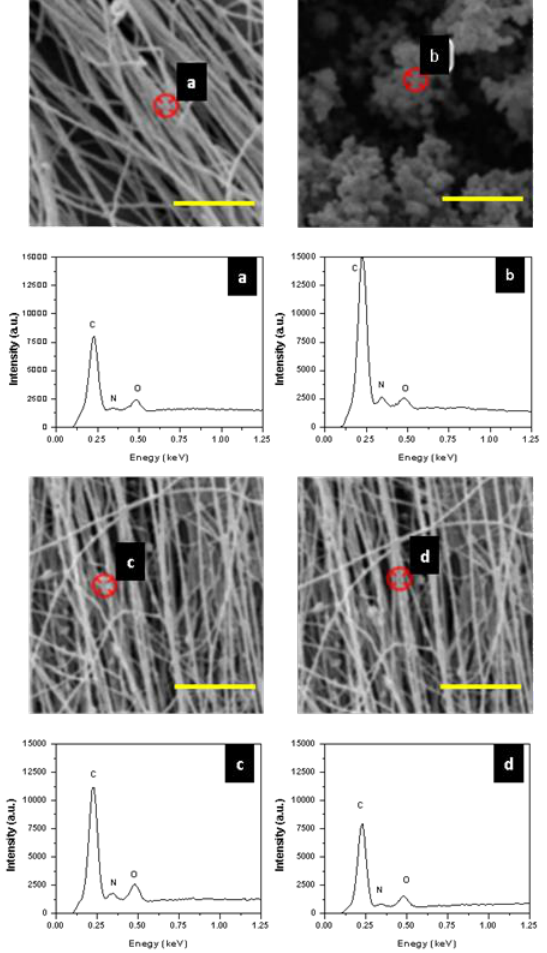
Figure 5. Energy-Dispersive X-ray Spectroscopy (EDS) surface analysis of ( a ) PEO 3%, ( b ) electrosprayed PANI-CSA, ( c,d ) 3%-2.5% side-by-side PEO-PANI fibers in knot and uniform areas, respectively. (Scale bar: 10 µm).